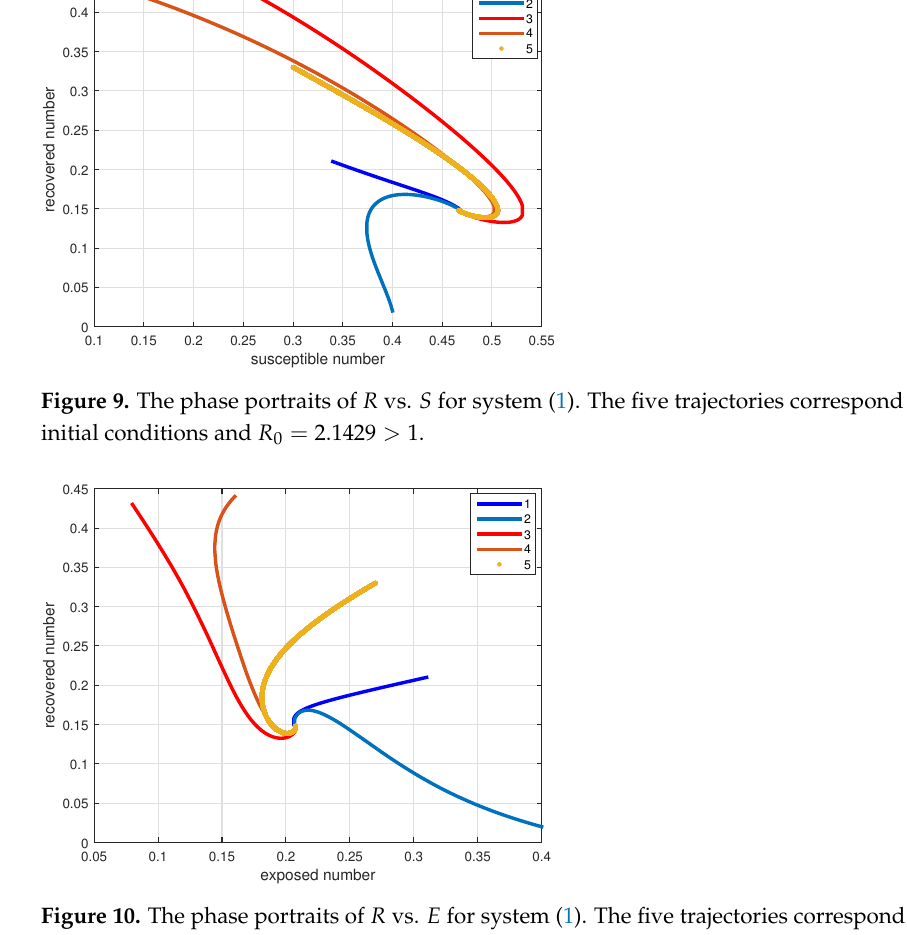
Figure 10. The phase portraits of R vs. E for system (1). The five trajectories correspond to different initial conditions and R 0 = 2.1429 > 1.